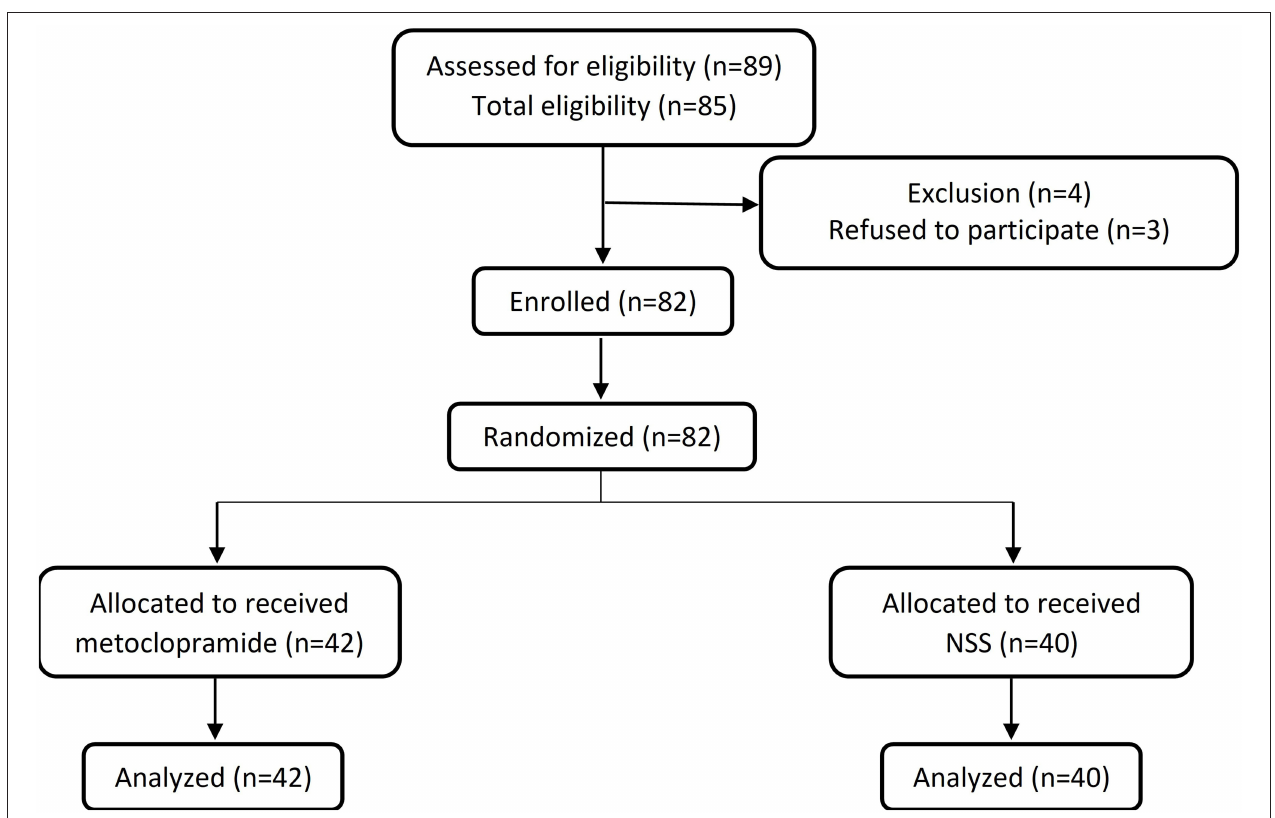
FIGURE 1 | Consort diagram of the